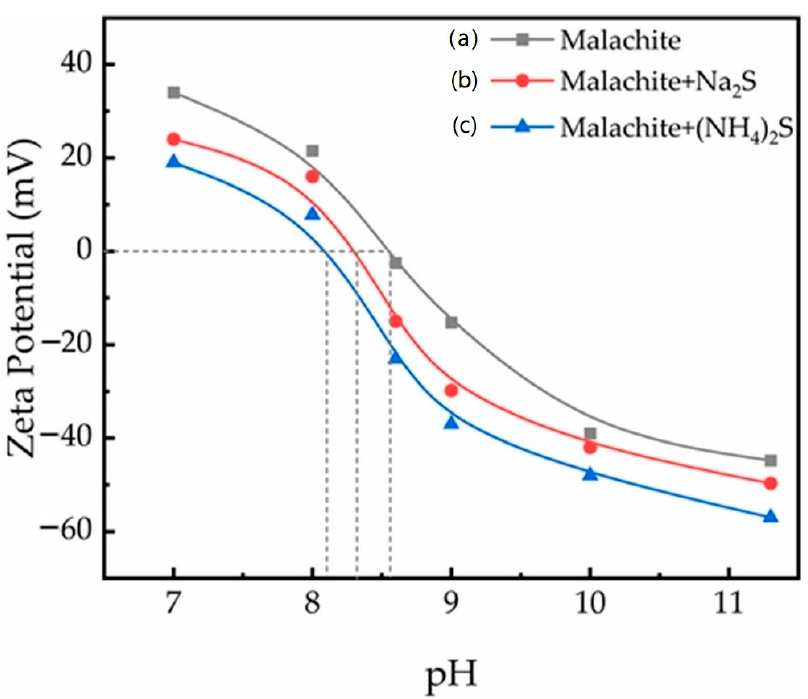
Figure 3. Zeta potential as follows: ( a ) malachite, ( b ) malachite + Na 2 S and ( c ) malachite + (NH 4 ) 2 S as a function of pH, Na 2 S = 6 × 10 − 2 mol/L, (NH 4 ) 2 S = 6 × 10 − 2 mol/L.